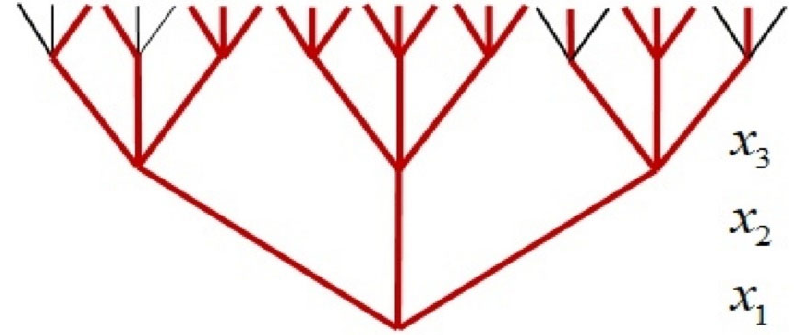
Figure 3. MZAPN of the given logical function from the example.